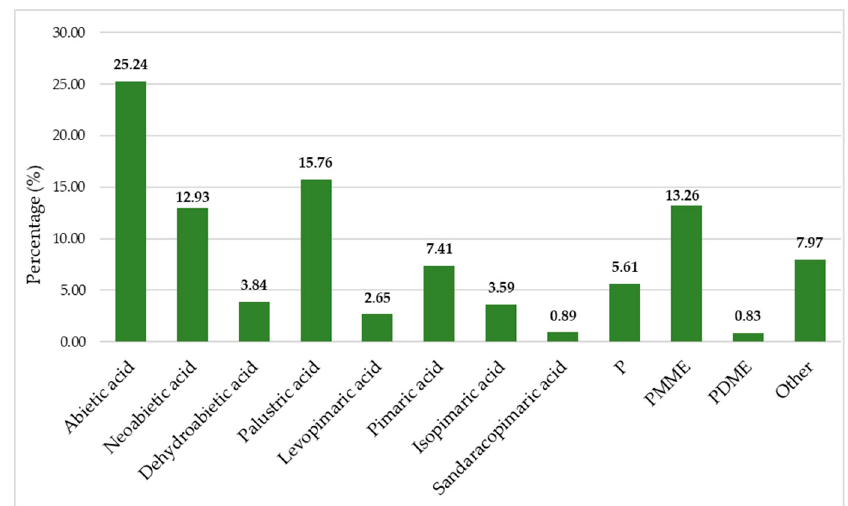
Figure 4. The mean percentage content of the constituents in the black pine’s heartwood acetone extraction from the Peloponnese (P = pinosylvin, PMME and PDME = monomethylether and dimethylether of pinosylvin, respectively).